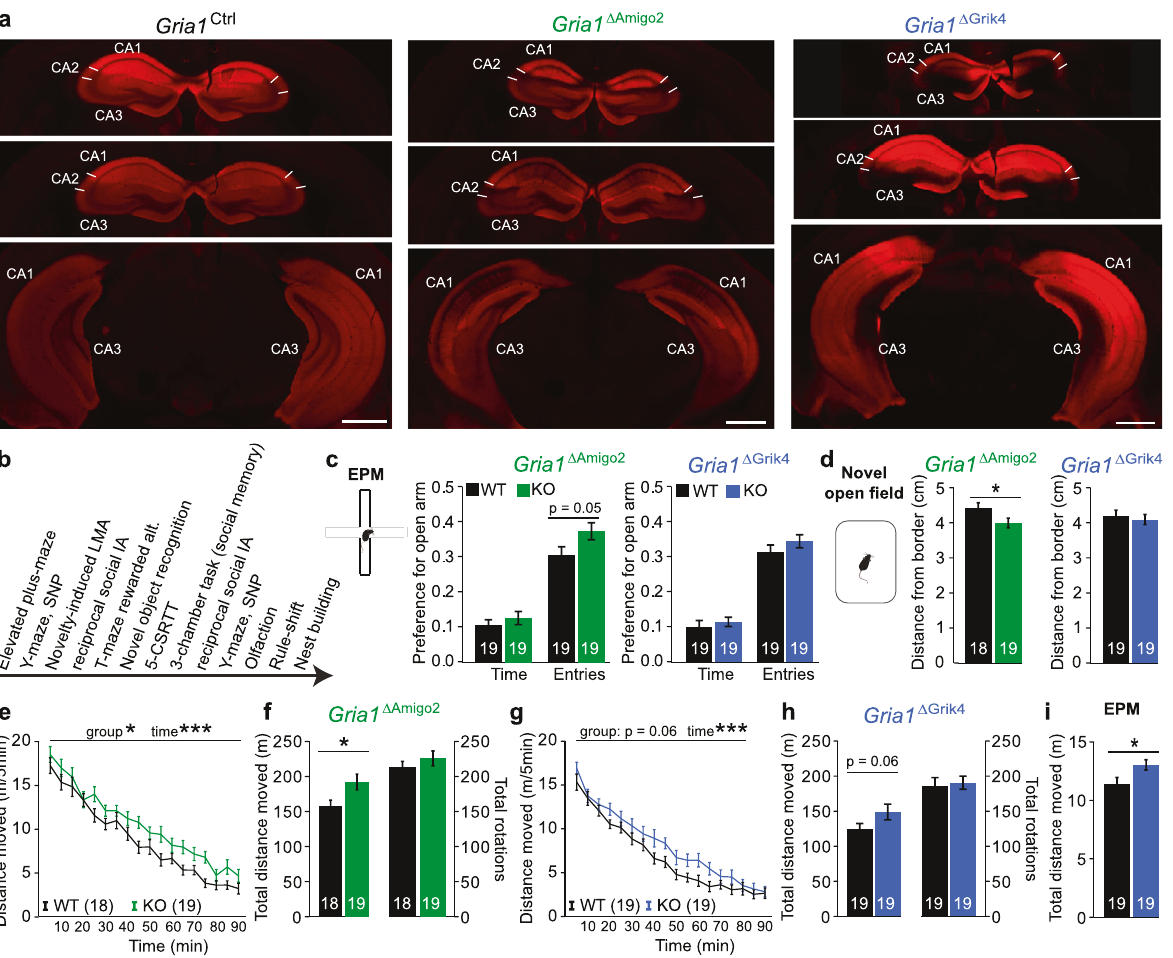
Fig. 2 Ablation of GluA1 from CA2/CA3 mildly elevates locomotion. a Confocal images of anti-GluA1 staining (red) of slices of dorsal (top) and ventral (bottom) hippocampus from the groups named above. Scale bar, 1 mm. b Chronological series of behavioural tests conducted in the transgenic mixed-sex cohorts. c Preference for the open arms of the elevated plus-maze (EPM) calculated from residence time or the number of entries, as indicated. d Average distance from border during 90 min locomotor activity measurement in a novel open fi eld. e – h Novelty-induced locomotor activity displayed in 5 min intervals ( e , g ) or as total distance moved in 90 min ( f , h ). i Distance moved on the EPM. In ( c – i ), the cohort is identi fi ed above the panels and colour-coded, with KO mice and control groups of each cohort in colour and black, respectively. N — numbers are stated in colour legends or bars of each panel. The two cohorts were treated separately for statistics. RM-ANOVA was used for analysing data over time ( e , g ), univariate ANOVAs for the remainder, ANOVAs used genotype and sex as independent variables; see Supplementary Tables 3 and 4 for exact statistical results. All graphs represent mean ± s.e.m. *** P < 0.001, * P <